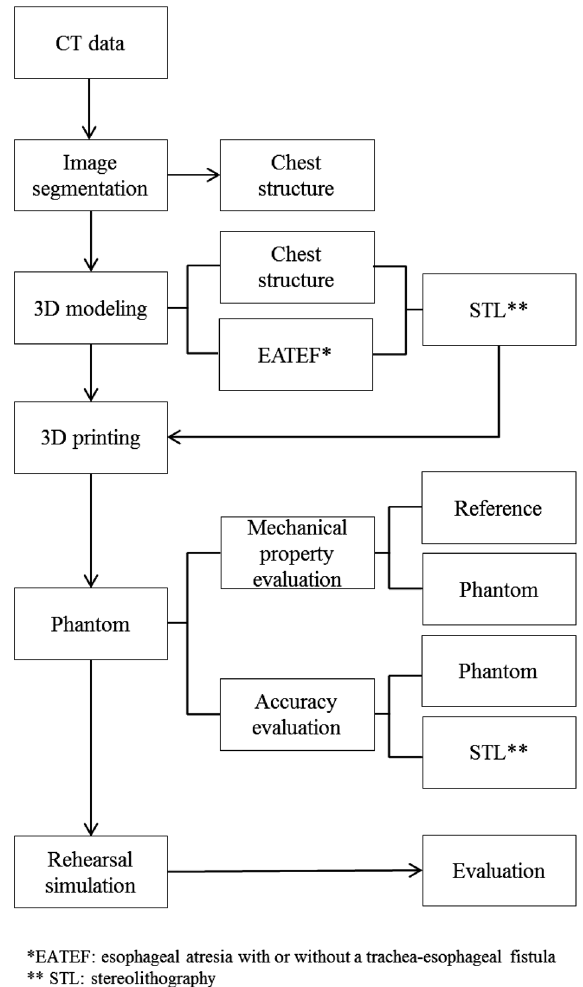
Figure 1. Flowchart of the procedure for making 3D-printed infant VATS phantom.